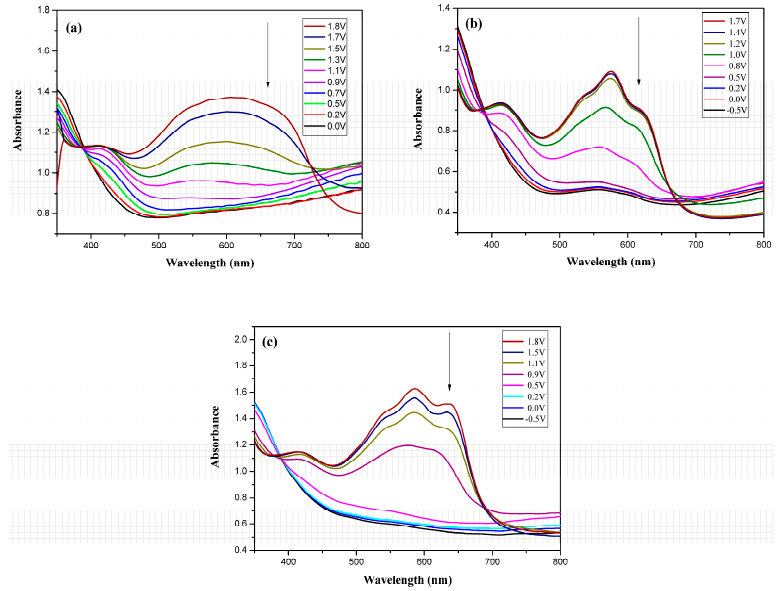
Figure 7. UV-visible spectra of ( a ) PtCz/PEDOT ( b ) PtCz/PProDOT-Me 2 , and ( c ) PtCz/PProDOT-Et 2